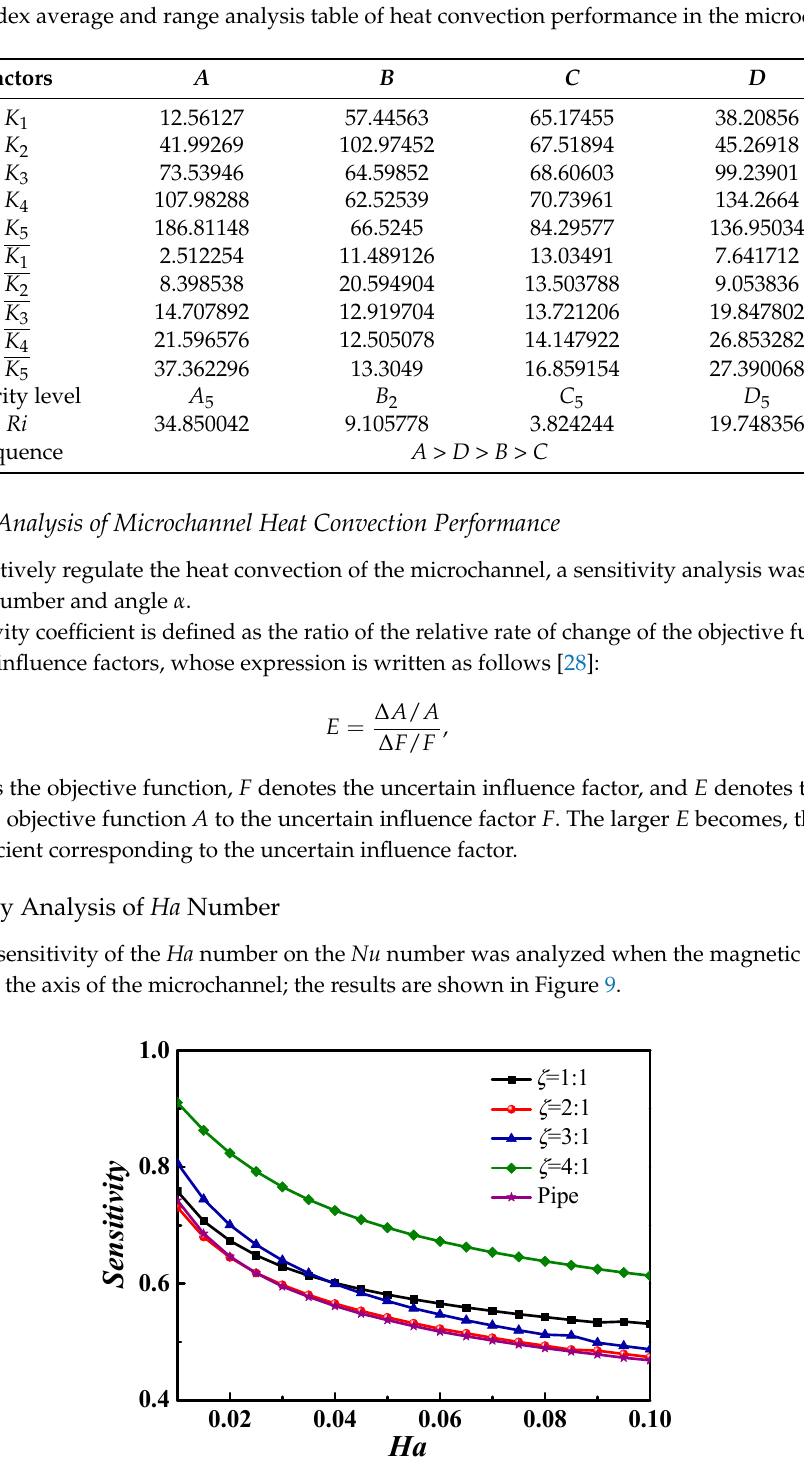
Figure 9. Sensitivity of the Ha number to the Nu number with various cross-sections.